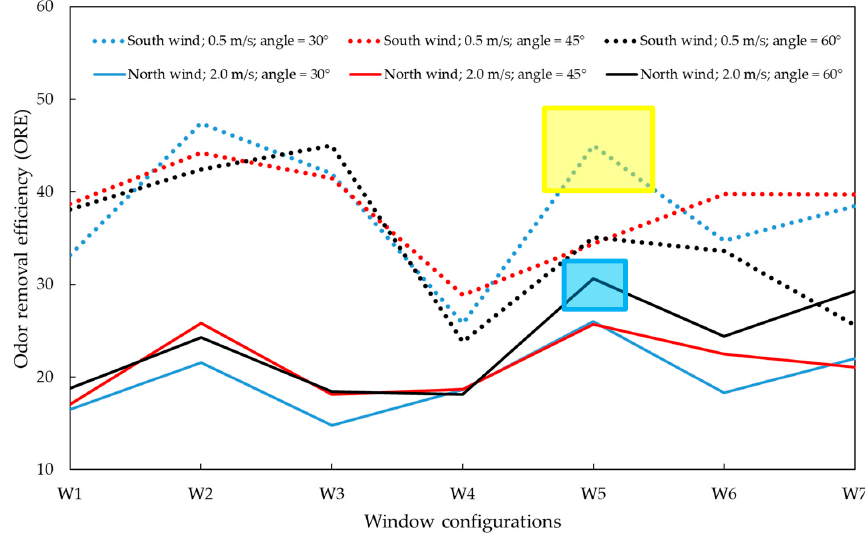
Figure 9. Odor removal efficiency for the cases with 0.5 m/s south wind and 2.0 m/s north wind.